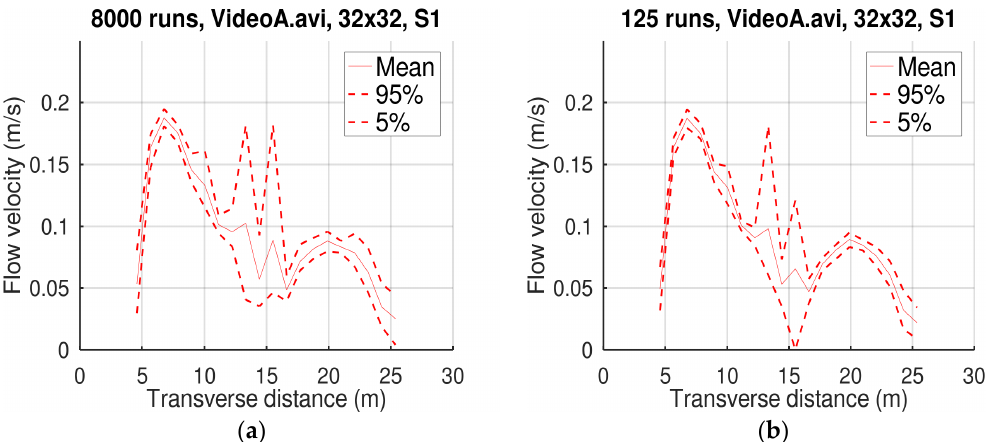
Figure 2. Mean velocity profile and confidence intervals of Monte Carlo simulations with 20 3 ( a ) and 5 3 ( b ) runs, and L = 16.